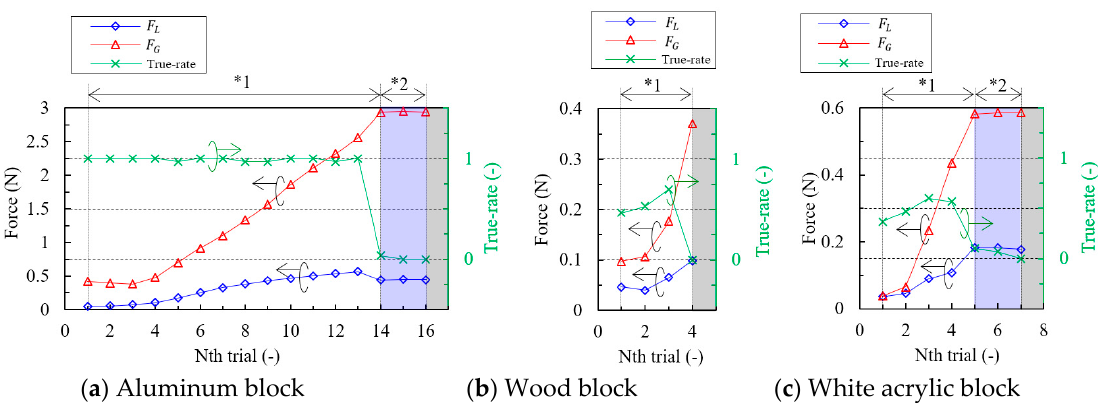
Figure 11. Forces and True-rate at each gripper lifting: ( a ) Aluminum block; ( b ) Wood block; ( c ) White acrylic block. Note that vertical scales are different for each block. * 1 Processed via ‘Route-1’ and * 2 Processed via ‘Route-2’ as explained in Section 2.6, Figure 9.